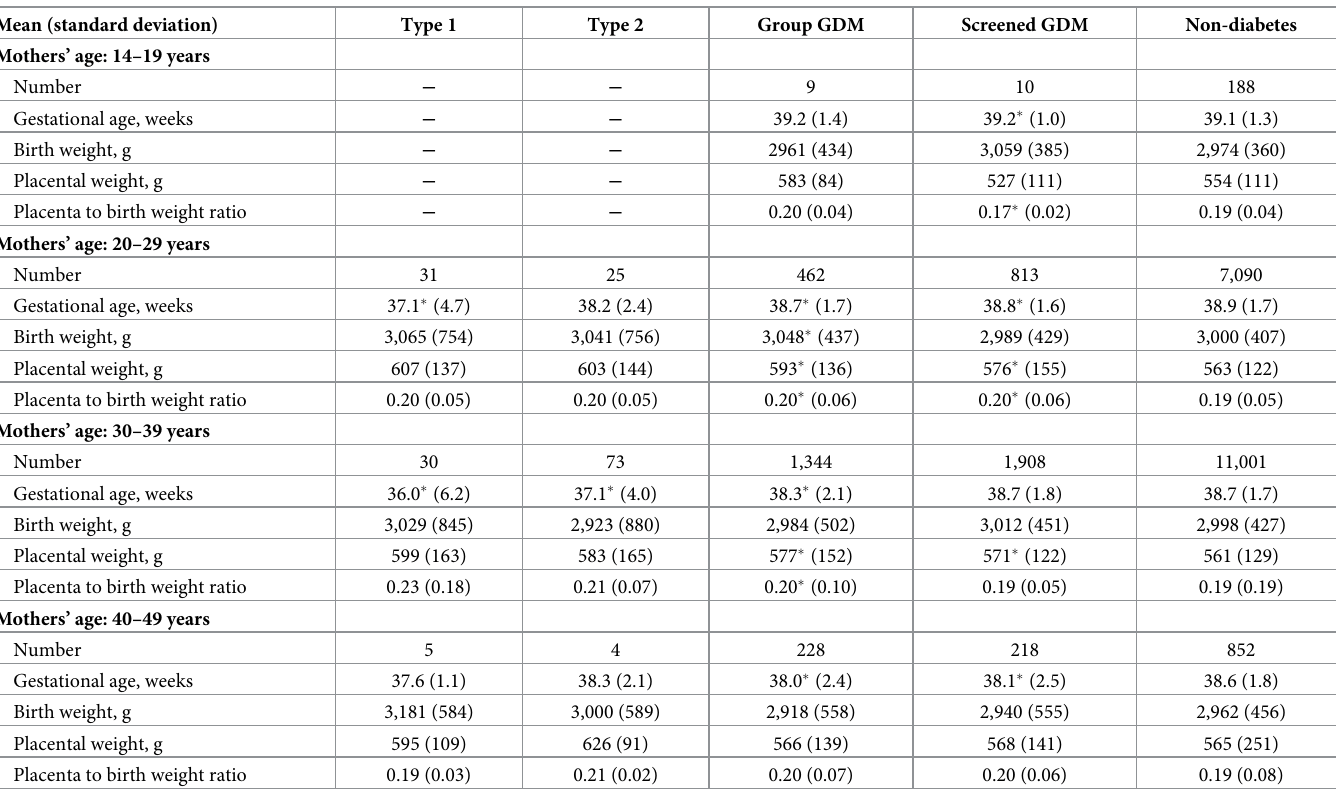
Table 4. Perinatal data of neonates of mothers with various types of diabetes in relation to maternal age.